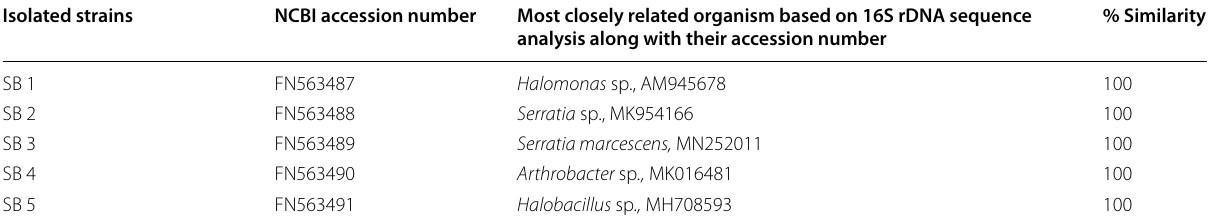
Table 4 Molecular characterization of the isolates Isolated strains NCBI accession number Most closely related organism based on 16S rDNA sequence analysis along with their accession number